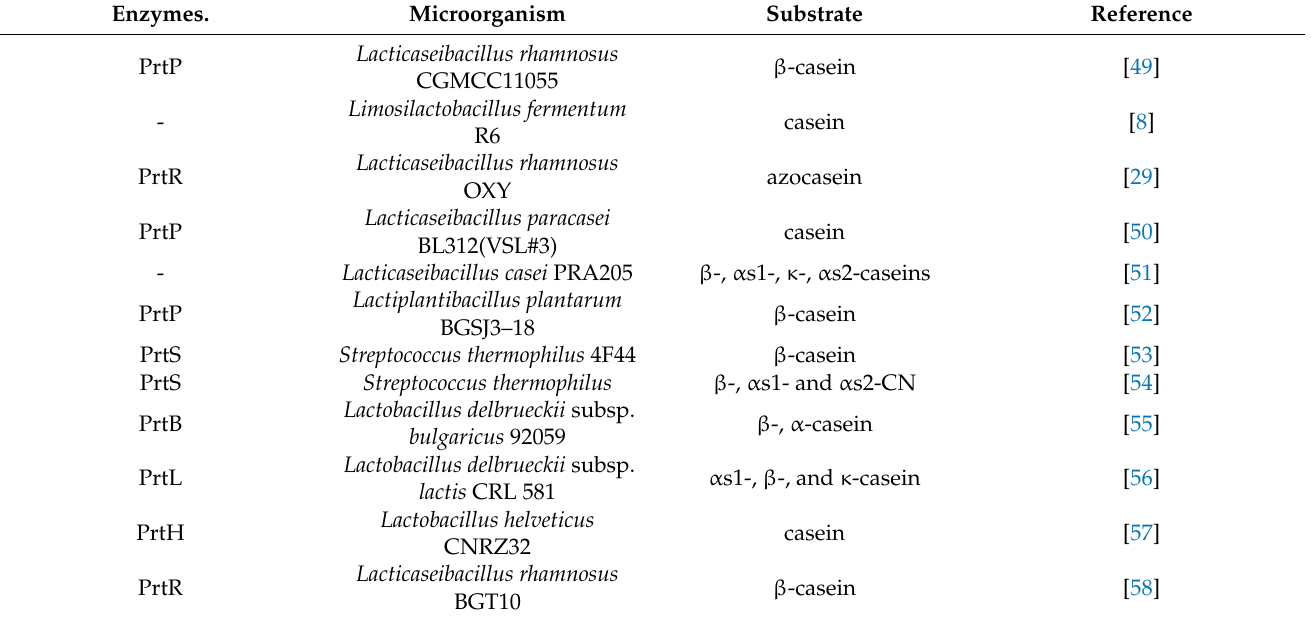
Table 1. Selected proteolytic